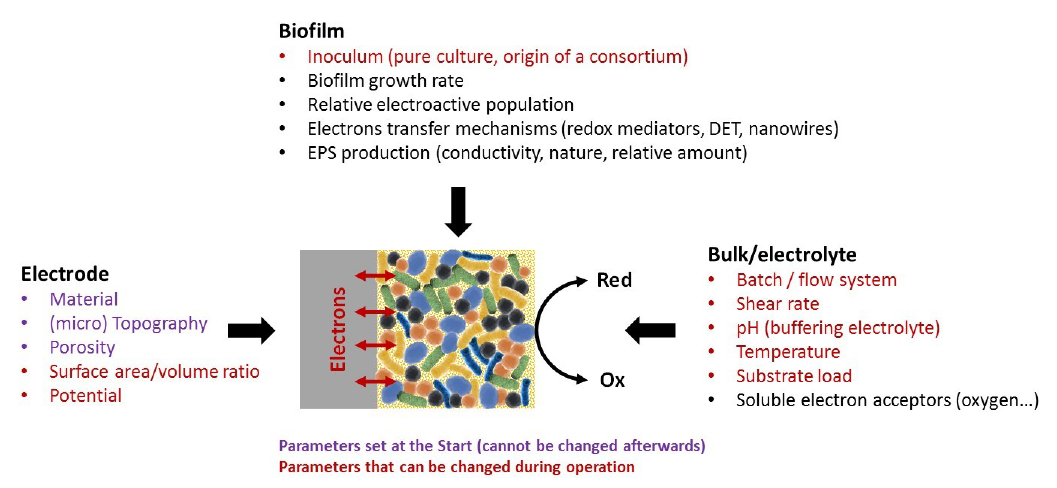
Figure 2. Electrode, biofilm, or electrolyte-related parameters known to have a significant impact on the formation and performance of microbial electrocatalytic